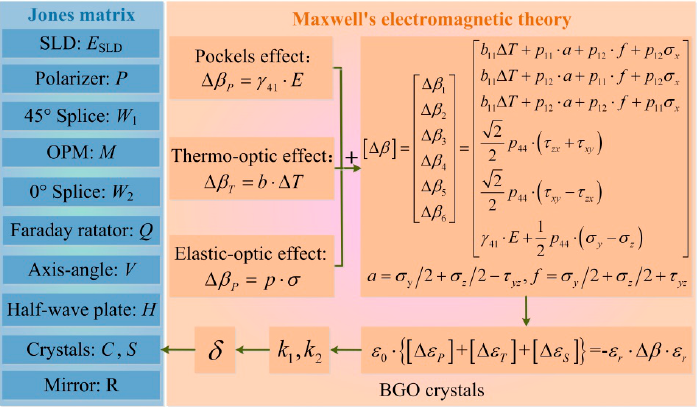
Figure 2. Simulation platform of OVS considering the applied electric, temperature, and stress fields and axis-angle errors.